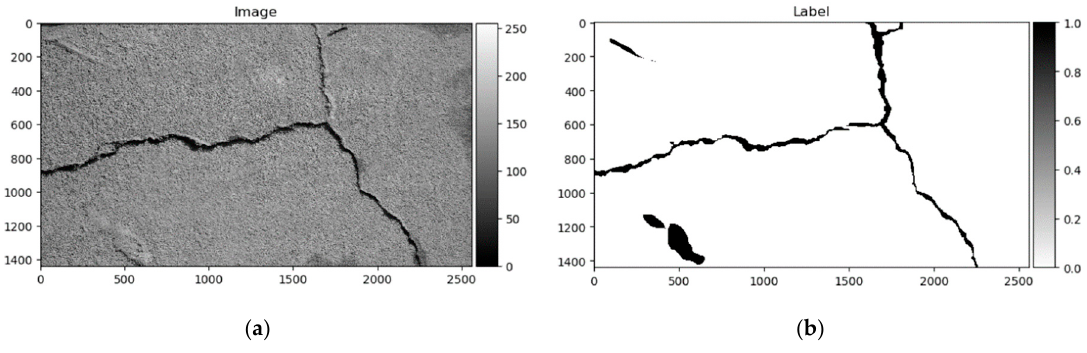
Figure 9. Crack500 data sample. ( a) Image; ( b ) ground truth.